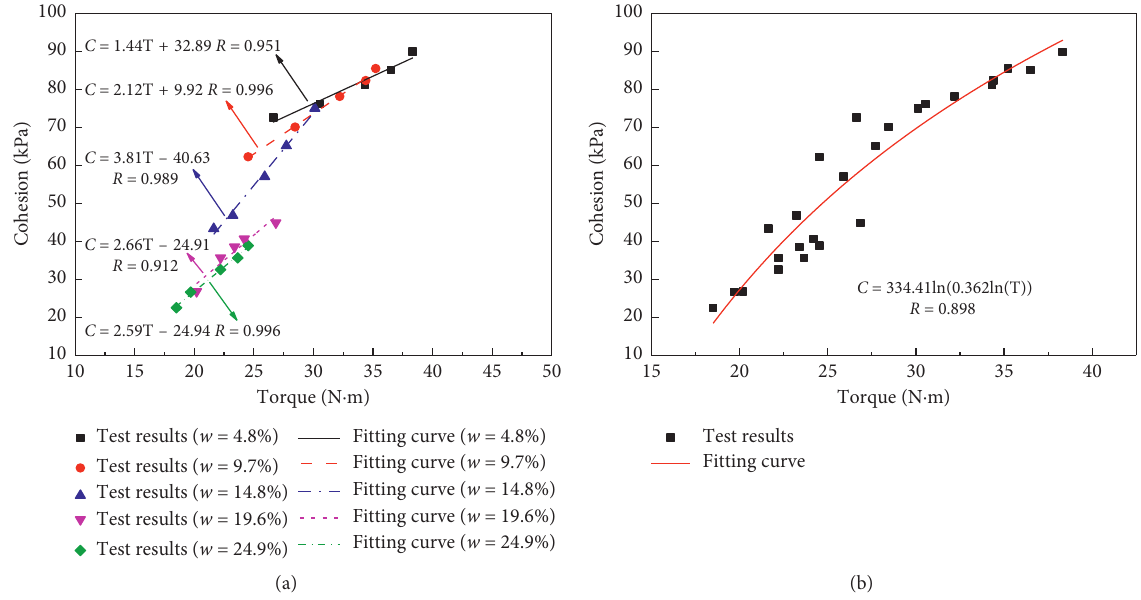
Figure 11: Relationship between torque and cohesion: (a) considering water content and (b) without considering water content.